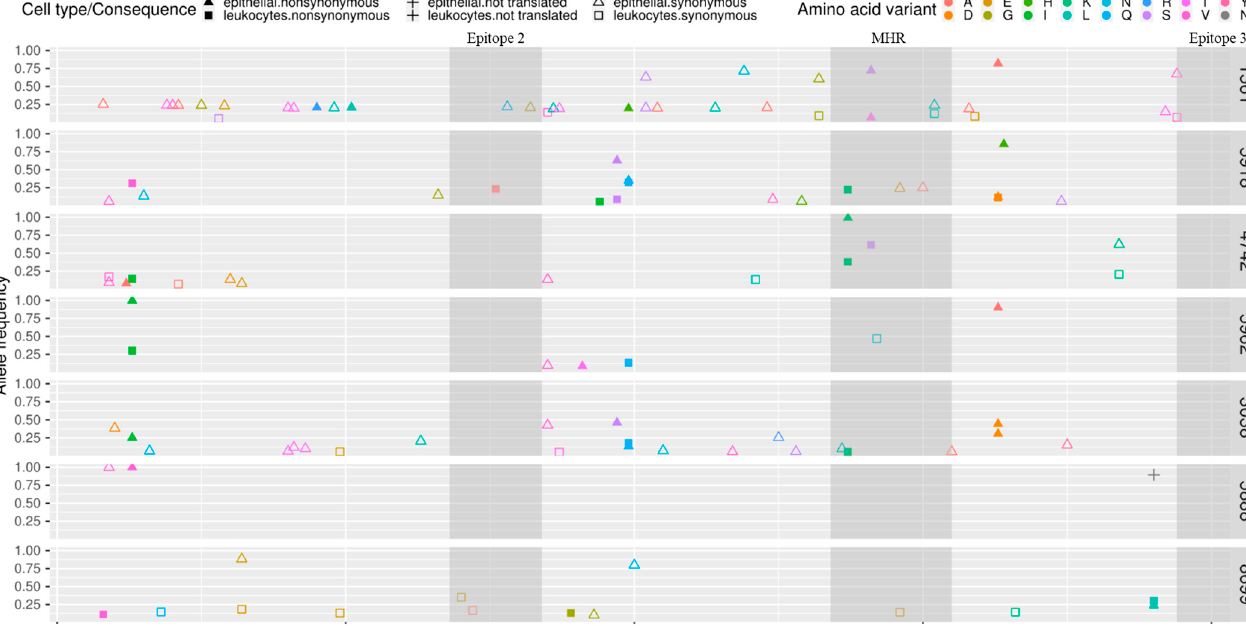
Figure 4. Distribution of synonymous and non-synonymous single nucleotide variants (SNVs) in SRLVs gag gene se- quences encoding capsid protein derived from PBLs and milk epithelial cells of goats analyzed in this study. MHR-major homology region.